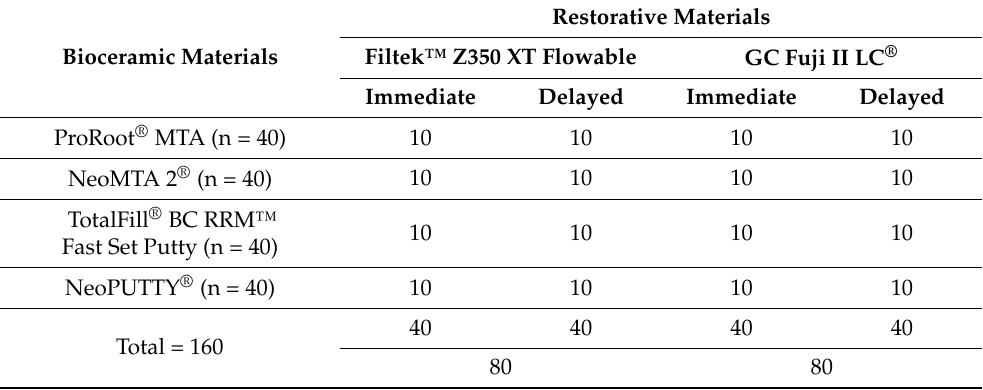
Table 1. Distribution of experimental groups.